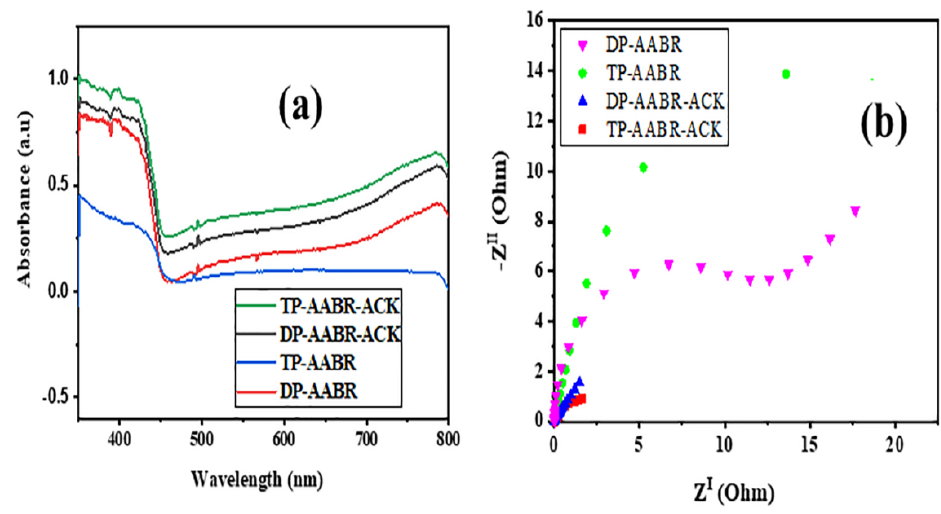
Figure 6. ( a ) UV–vis absorption spectra; and ( b ) EIS Nyquist plot of the synthesized